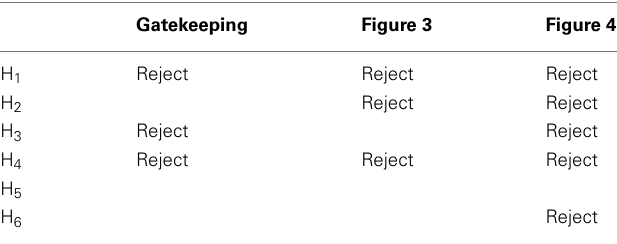
Table 1 |Testing result of gatekeeping procedure and the two modified graphical